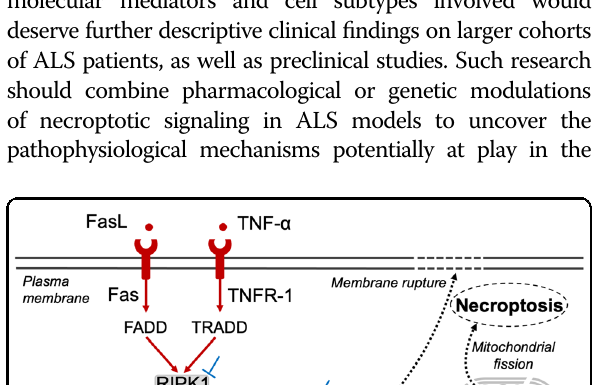
phosphorylated, PGAM5 phosphoglycerate mutase family member 5, RIPK receptor-interacting protein kinases, TNF α tumor necrosis factor α , TNFR1 tumor necrosis factor receptor 1, TRADD tumor necrosis factor receptor type 1-associated